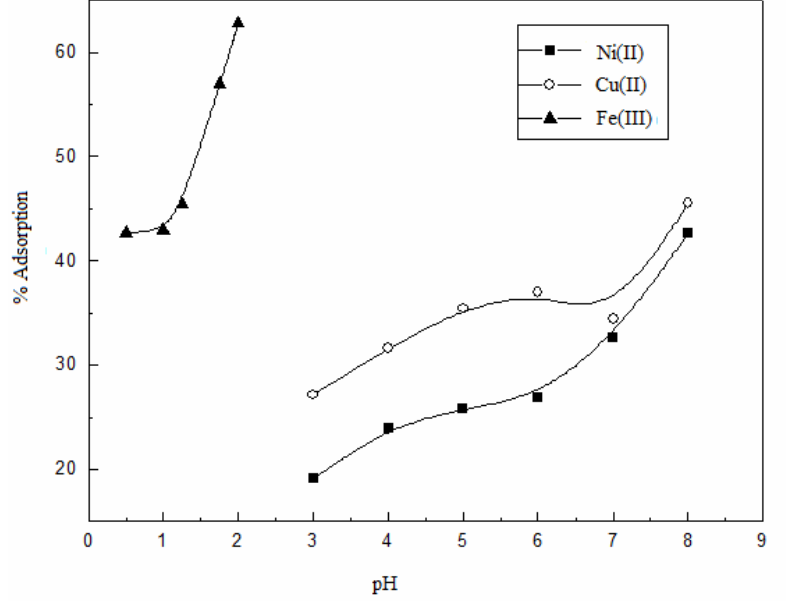
Figure 2. Adsorption of metals on CC: Effect of p